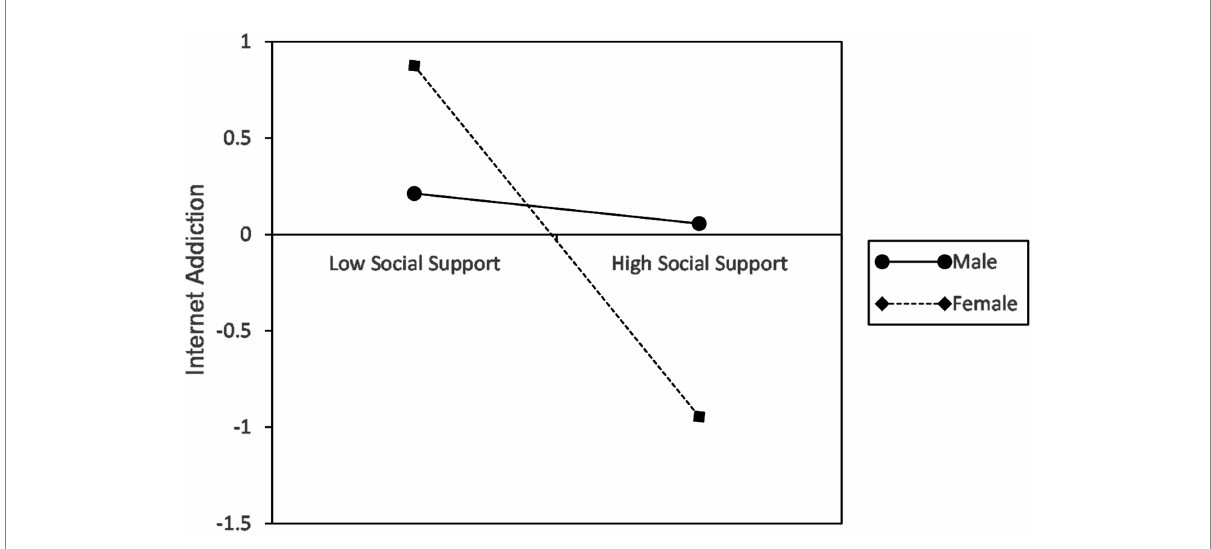
FIGURE 2 Moderating effect of gender on social support and Internet